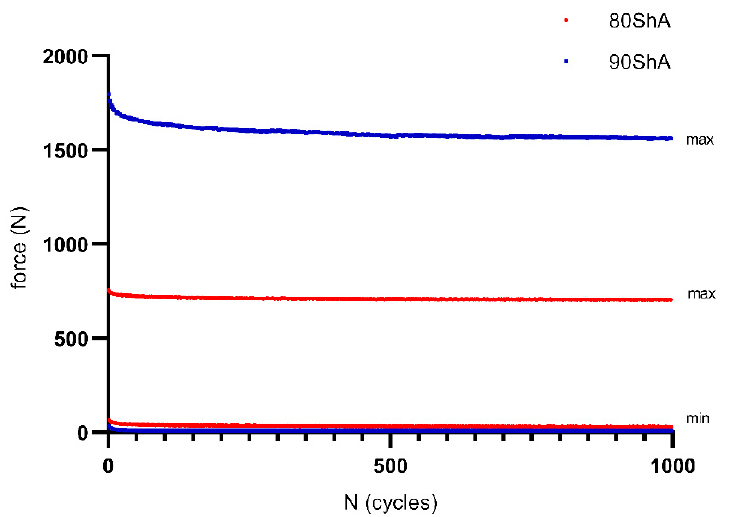
Figure 5. Cyclic response of PS (pure shear) specimens during pre-cycling .